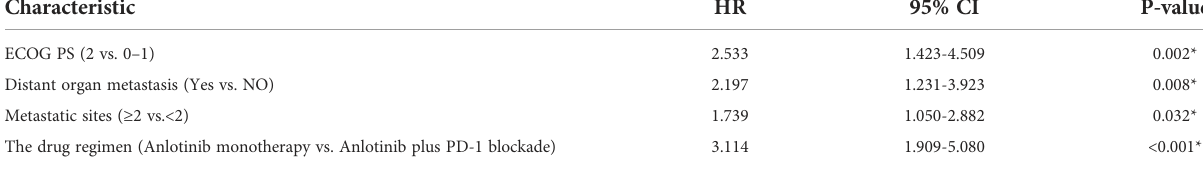
TABLE 8 Multivariate Cox regression analysis of PFS of 98 advanced esophageal squamous cell carcinoma patients.